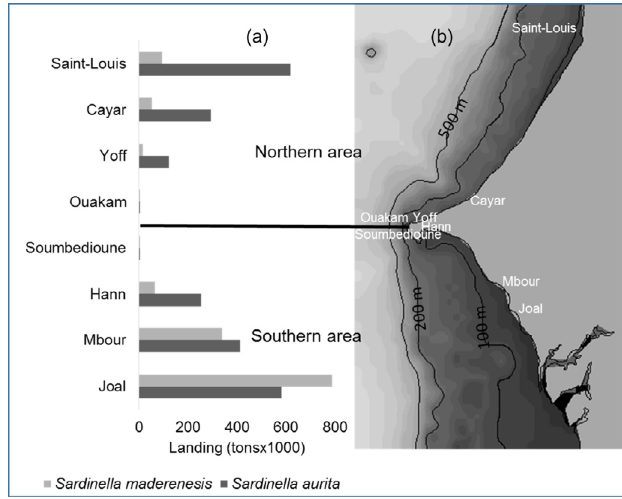
Fig. 2. (a) Total landing of Sardinella aurita (black bars) and S. maderensis (gray bars) by landing port summed over the period 2004 – 2013. (b) Map of landing ports along the Senegalese coast. The artisanal fl eet operates generally within the area limited by the 500 m